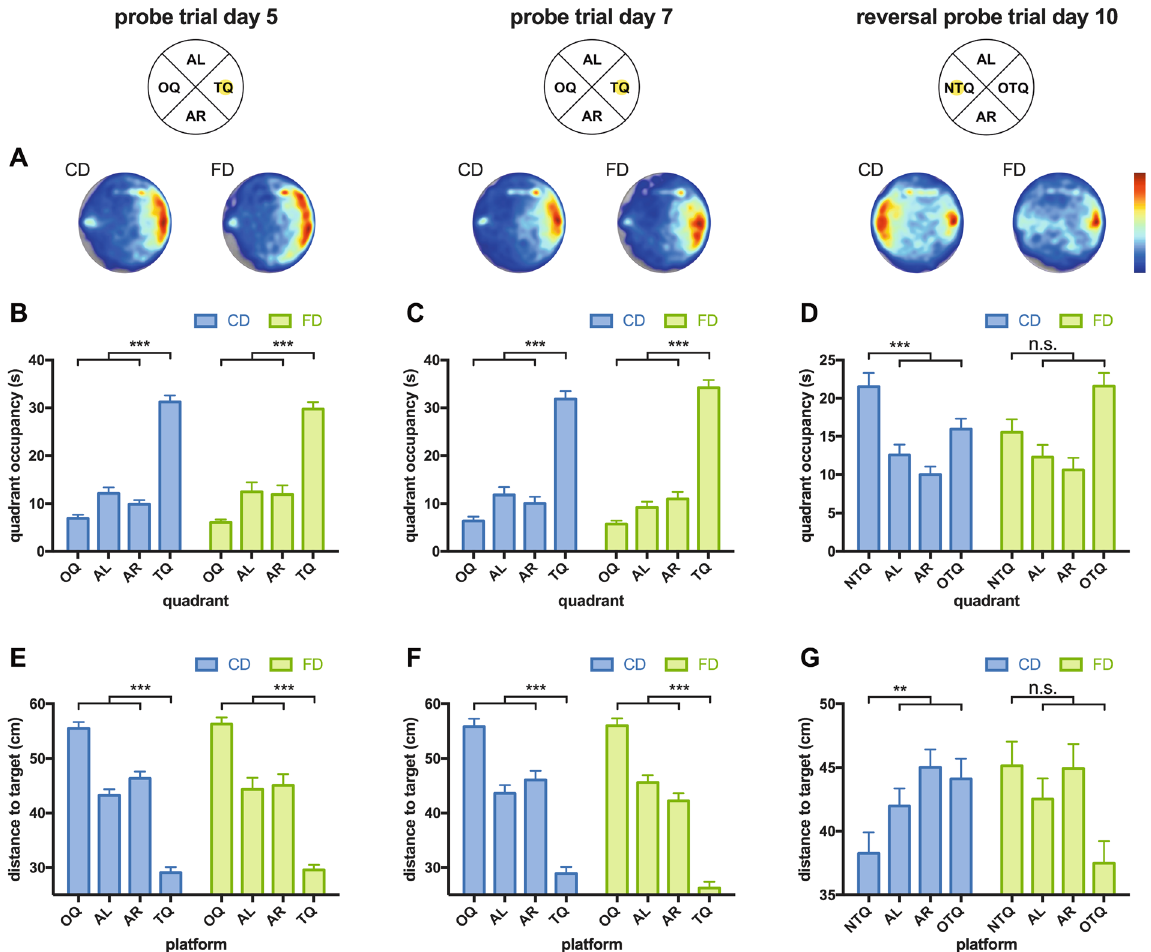
Figure 3. Morris water maze probe trial data. The figure shows Morris water maze probe trial data regarding probe trials delivered on days 5, 7 and 10. ( A ) Cumulative swim track representations (heat maps) are shown for both groups and for each day. Relative occupancy values during the probe trials in the Morris water maze are indicated by the colour code (see colour bar; red denotes high occupancy, blue denotes low occupancy values). ( B–D ) Quadrant occupancy during probe trials on day 5 ( B ), day 7 ( C ) and during the reversal probe trial on day 10 ( D ). ( E–G ) Average distance to the target location (average proximity) during probe trials on day 5 ( E ), day 7 ( F ) and during the reversal probe trial on day 10 ( G ). TQ = target quadrant, AL = adjacent left, AR = adjacent right, OQ = opposite quadrant, OTQ = old target quadrant, NTQ = new target quadrant (former OQ). CD = F1 offspring of control dams. FD = F1 offspring of dams that received the folic acid-supplemented diet prior to mating. Data are presented as mean ± S.E.M; asterisks denote significant differences ( ** p < 0.01, *** p < 0.001; CD: n = 24, FD: n =